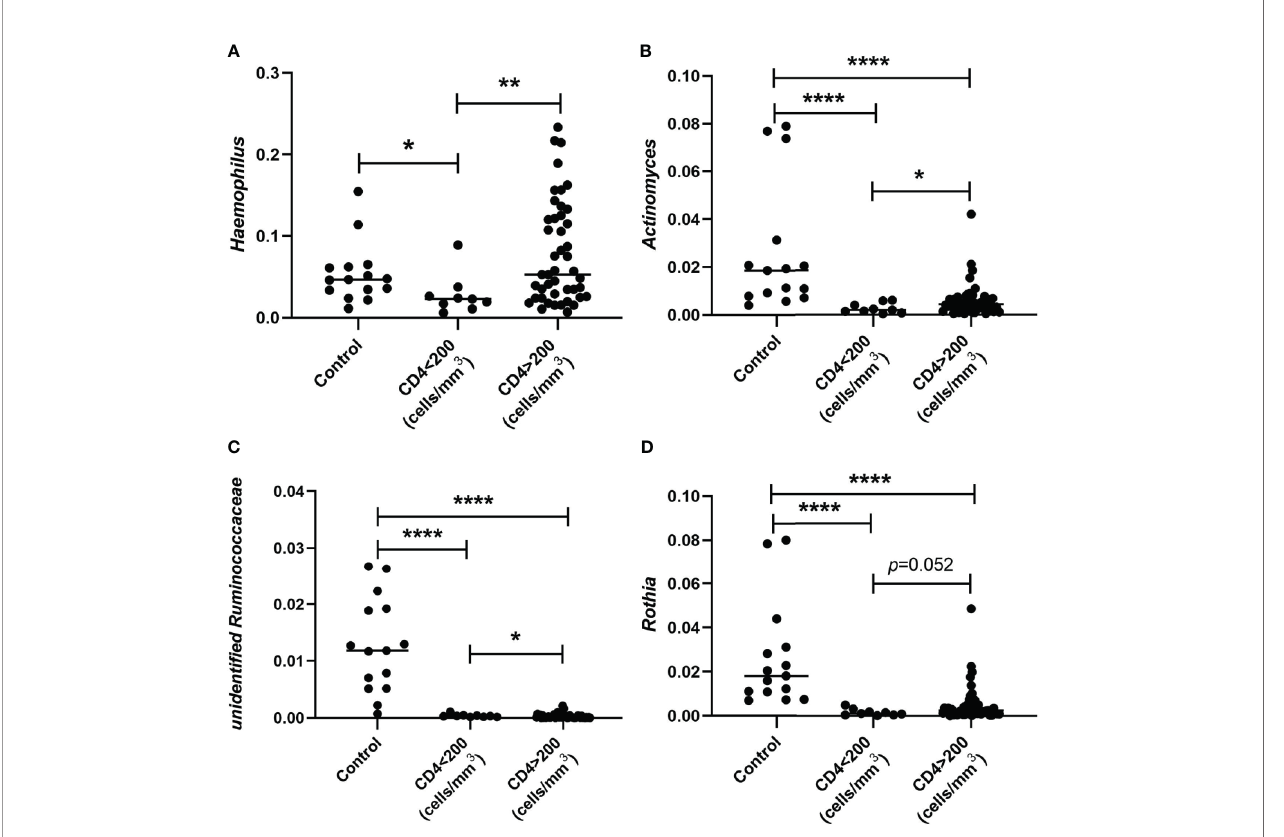
FIGURE 5 | Comparison of relative abundances of Haemophilus (A) , Actinomyces (B) , unidenti fi ed Ruminococcaceae (C) , and Rothia (D) collected from subjects whose CD4 + T cells were de fi ned < and CD4>200 cells/mm 3 and HIV-uninfected MSM controls. * p < 0.05; ** p < 0.01; **** p < 0.0001.